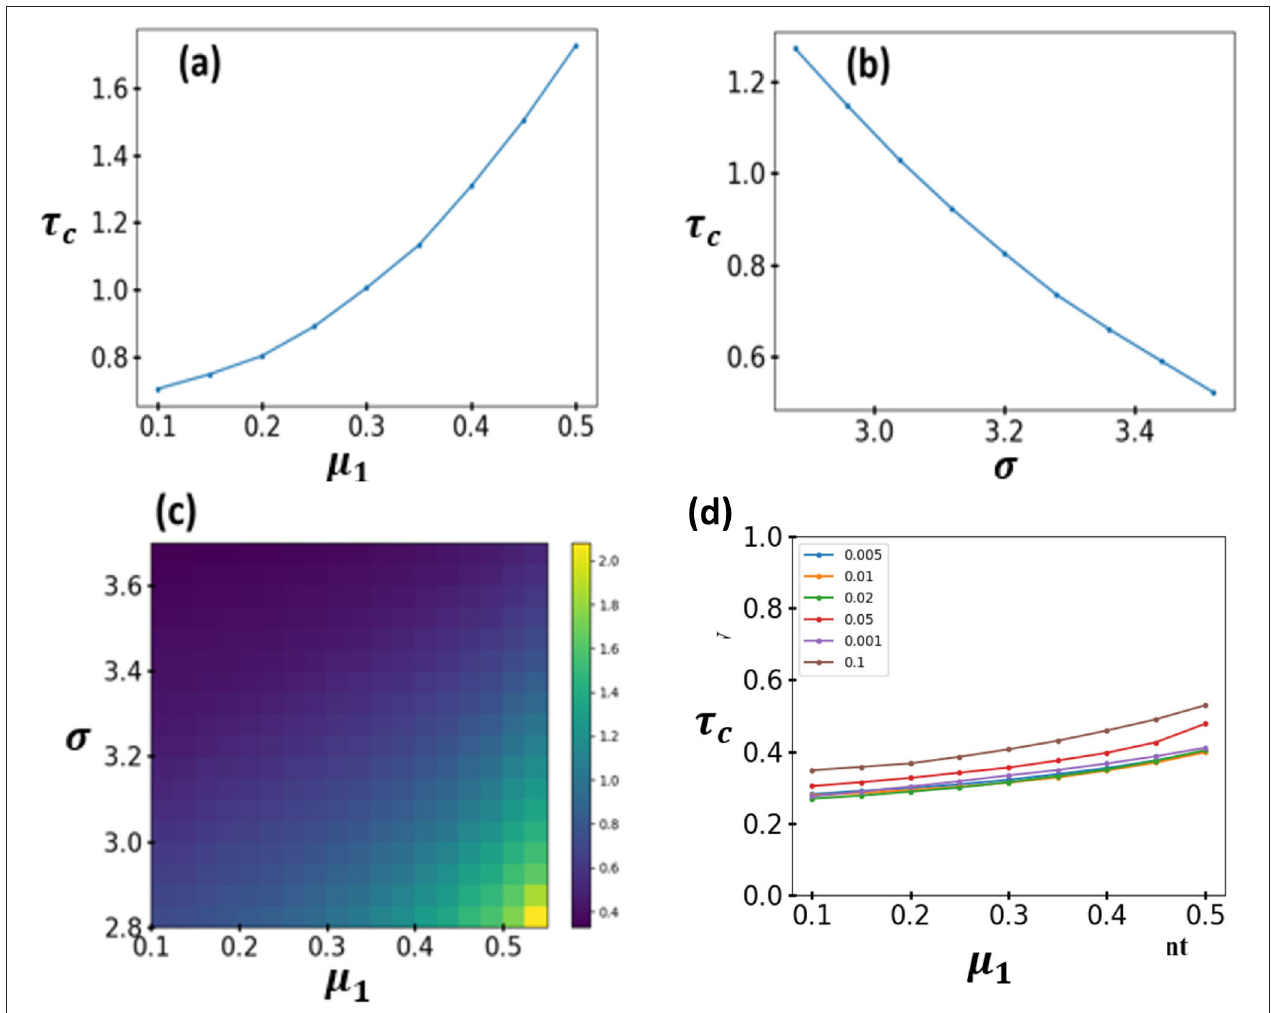
FIGURE 9 | The behavior of critical delay as a function of (a) µ 1 and (b) σ for a multiplex network with σ = 2.81 and µ 1 = 0.43, respectively. (c) Exhibits a heatmap in µ 1 and σ parameters space for the multiplex network. The colorbar represents the value of critical delay. The values of critical delay in (a–c) are calculated using a trained MLP-NN machine learning model. (d) The critical delay as a function of µ 1 for the multiplex network with σ = 3.82. Each line corresponds to a different value of threshold for frequency difference between the desynchronized node and the synchronized nodes, to determine if a state is solitary or not. For a value of threshold between 0.001 and 0.02, the predicted value of the critical delay using machine learning model does not see any significant change. Once the value of threshold exceeds 0.02, the machine learning model starts yielding bad predictions.